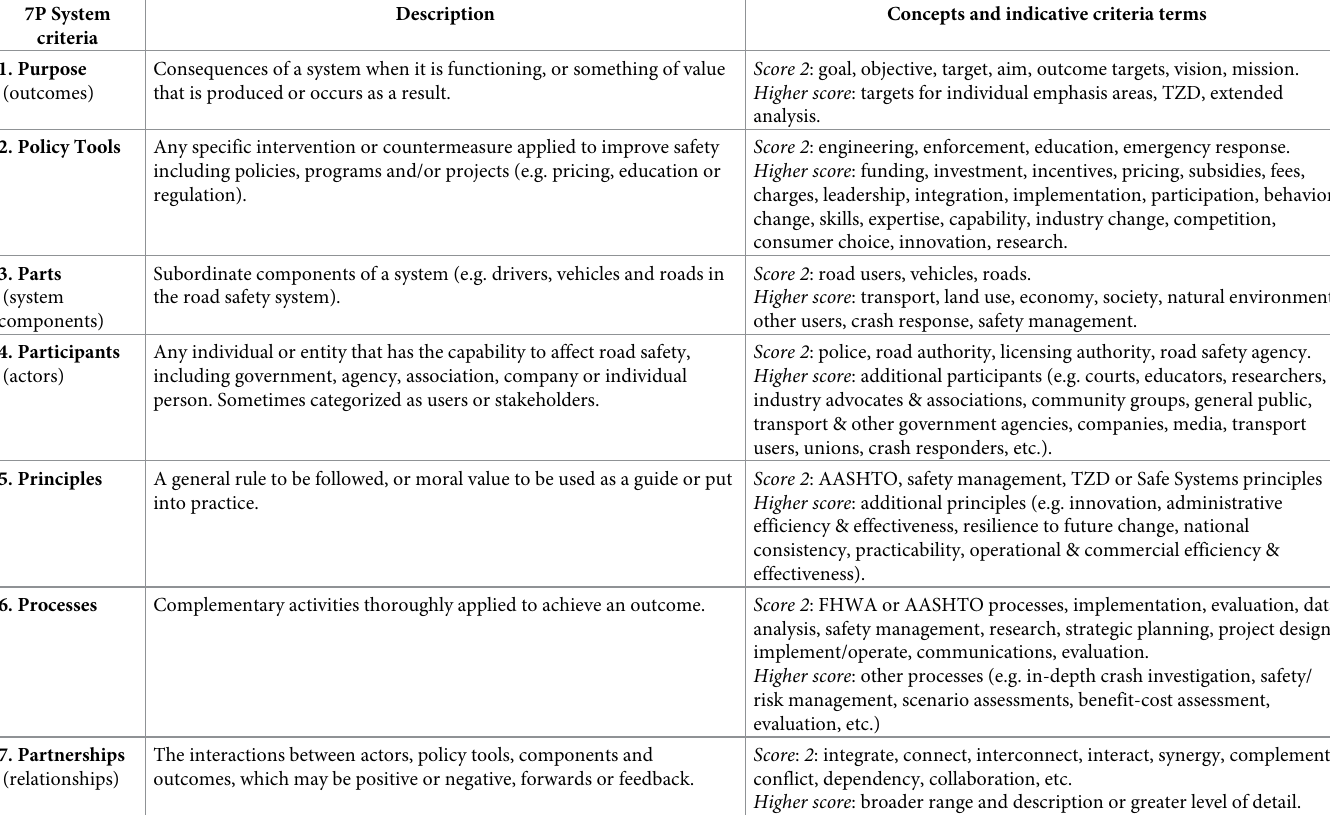
Table 2. Summary of 7P system criteria and scoring. 7P System